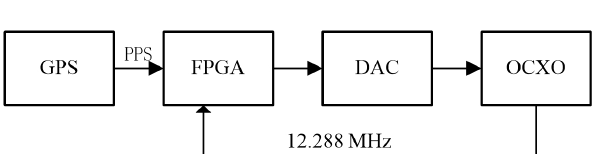
Figure 5. A flow chart representation of OCXO